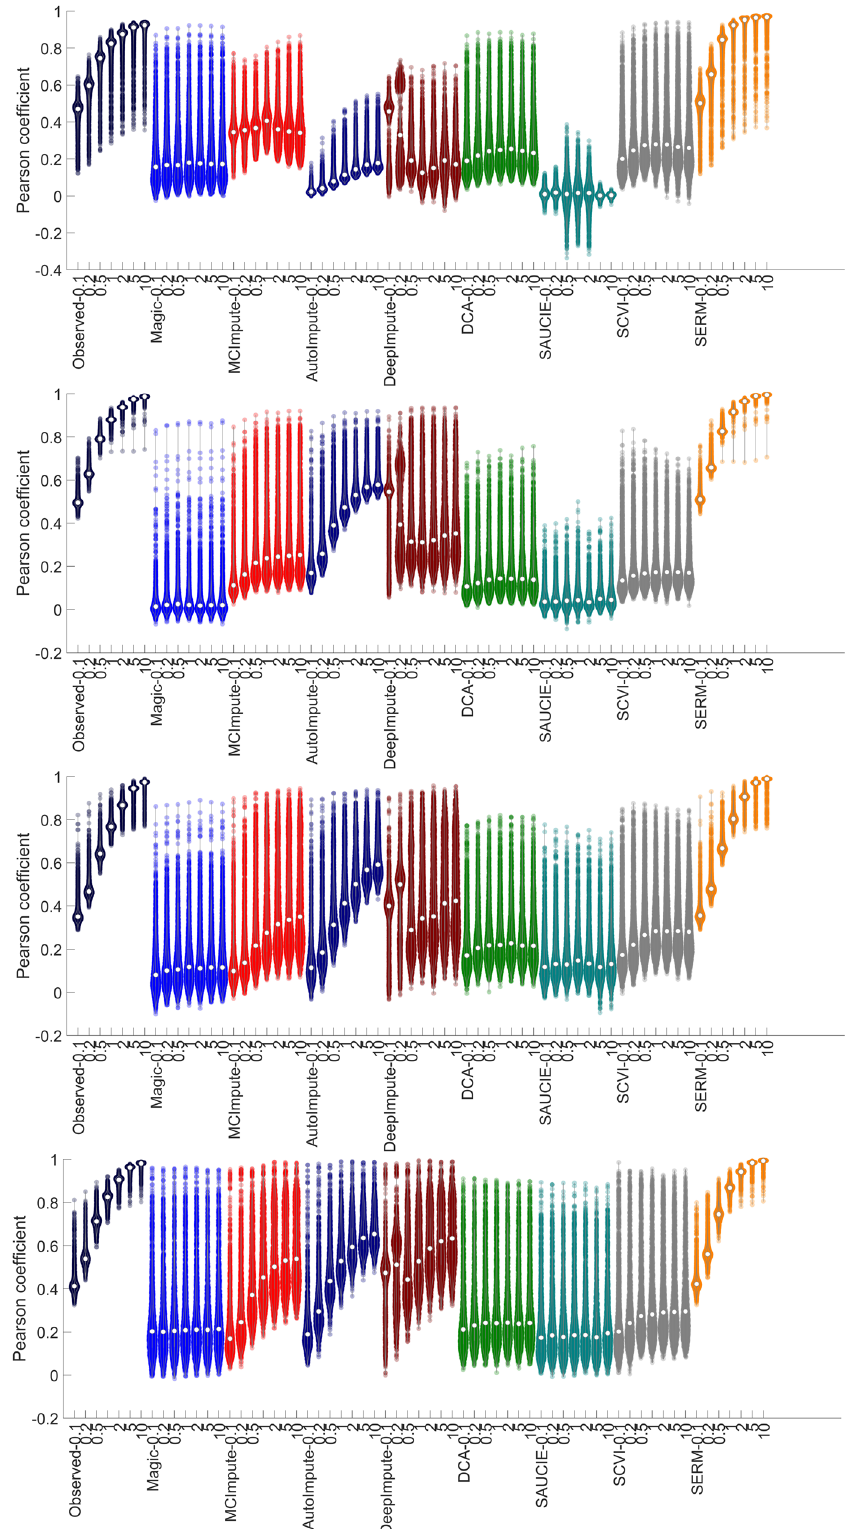
Fig. 4 | Pearson coef fi cient between the reference and imputed data by eight different techniques for different datasets (cellular taxonomy-row 1, mam- malian brain-row 2, mouse intestinal epithelium-row 3, and 3D neural tissue data-4th row). The sampling ef fi ciency (0.1 – 10%) to create the observed data are